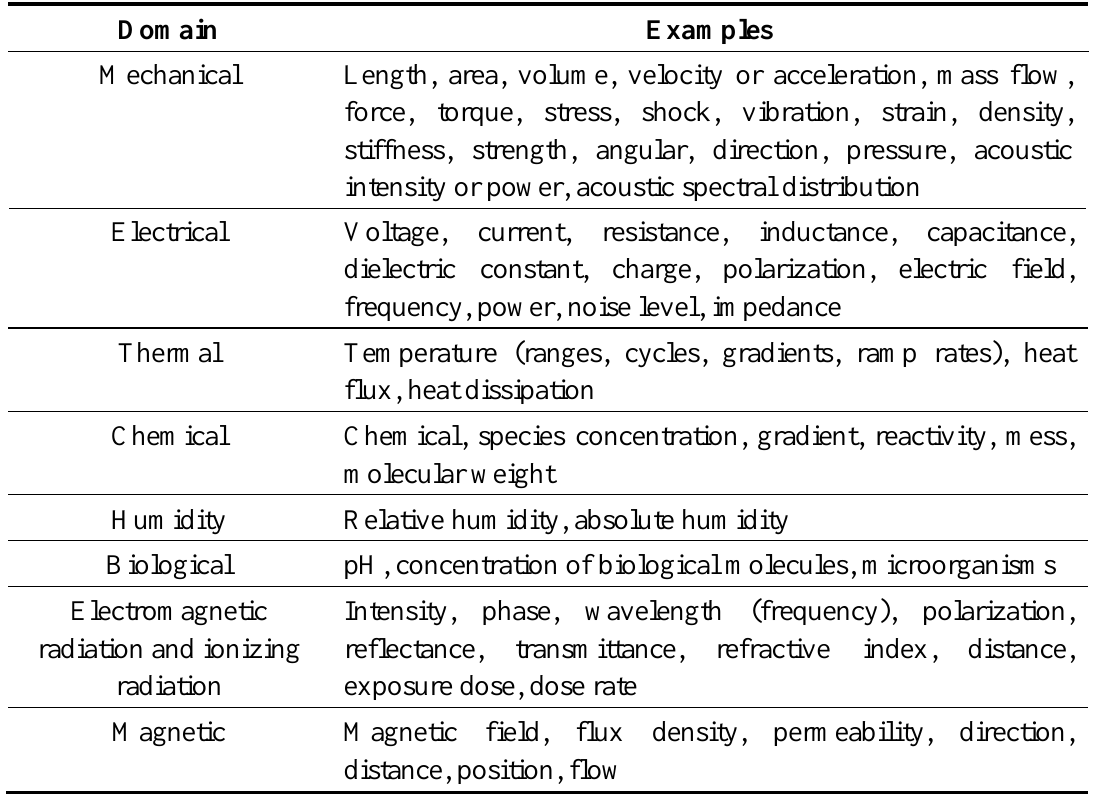
Table 1. Examples of parameters for PHM applications